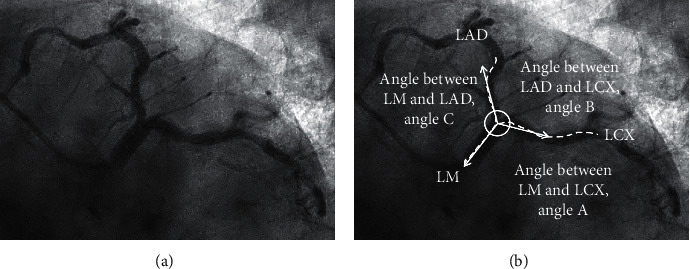
Measurement of left main bifurcation angles. Virtual lines were drawn from the branch origin under the LAO caudal view, and the 3 bifurcation angles were measured. LAD, left anterior descending artery; LAO, left anterior oblique; LCX, left circumflex artery; and LM, left main.